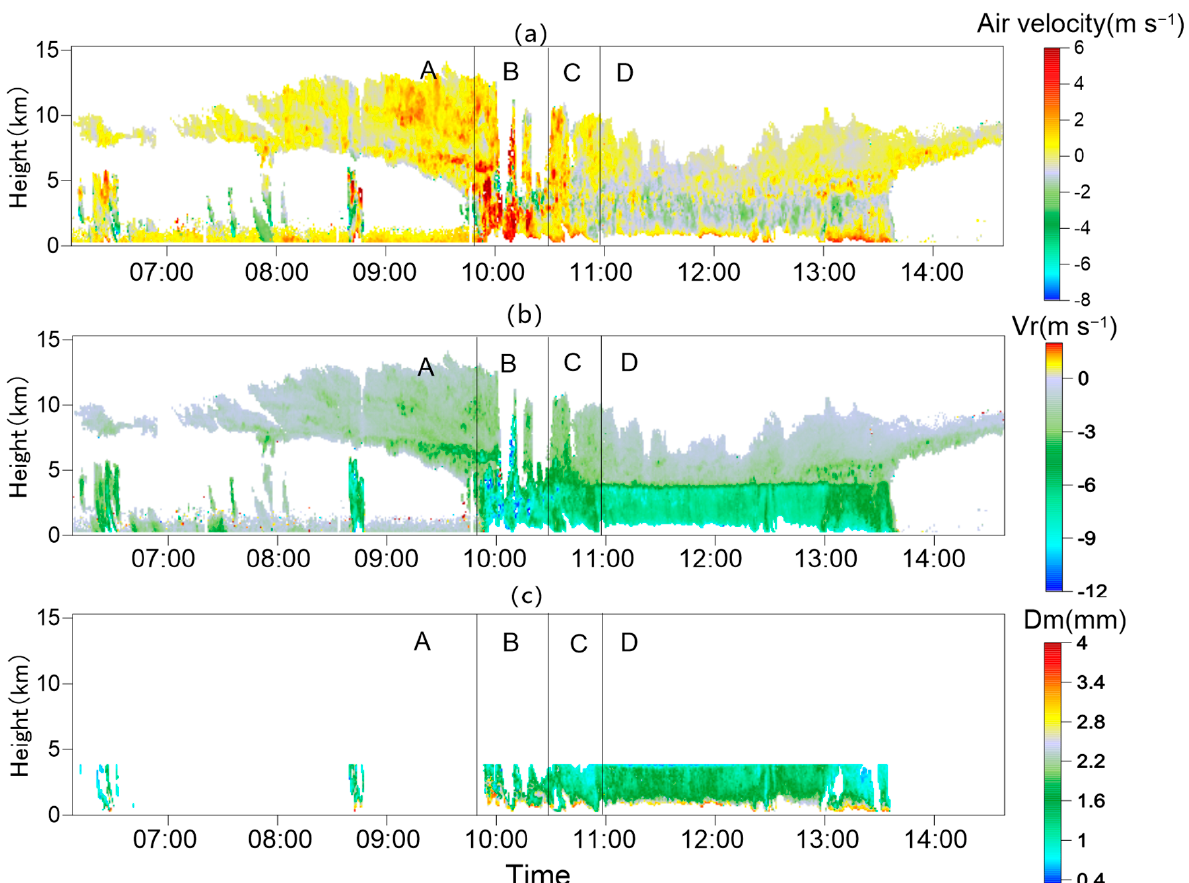
Figure 4. Cloud radar retrievals of the squall line on 6 May, 2016: ( a ) Vertical air velocity (unit: ms − 1 ), ( b ) free-falling velocity of raindrops in still air (unit: ms − 1 ), and ( c ) weighted average diameter (unit: mm). Different stages of the squall line are divided by black solid lines, and the time segment before the passage of the squall line, the strong convection time segment, the transition time segment, and the stratiform time segment are labeled A, B, C, and D, respectively.